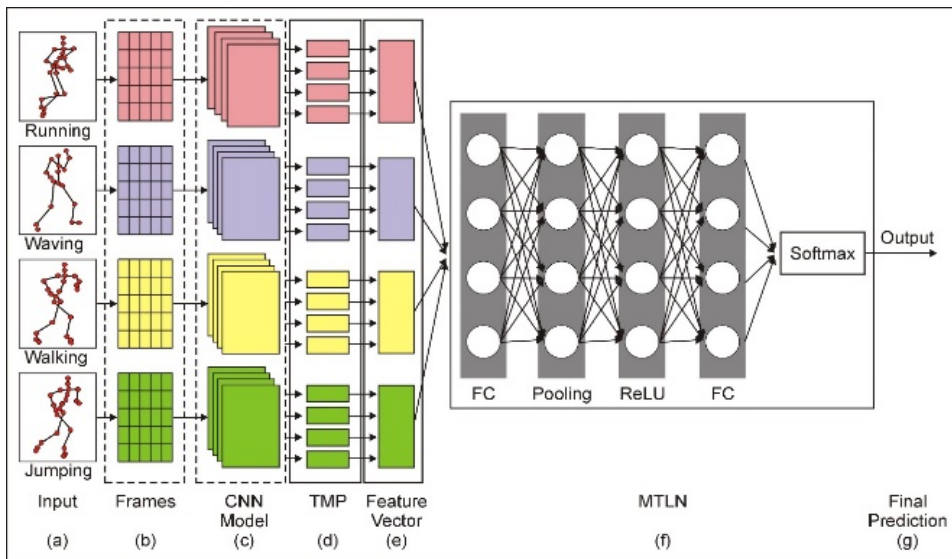
Figure 3. Developed model architecture. ( a ) Skeleton sequence; ( b ) frame generated from the given sequence; ( c ) framing joint points inserted into a deep CNN model; ( d ) TMP (temporal mean pooling) layer used to access the information from frames; ( e ) CNN output of four frames at equal time phases, where feature vectors are used to get the results, and each vector represents the skeleton sequence’s timing and spatial relation; ( f ) the developed MTLN containing a ReLU (rectified linear unit), a max-pooling layer, an FC (fully connected) layer, a Softmax layer, and another FC layer; ( g ) final output for testing and training data.